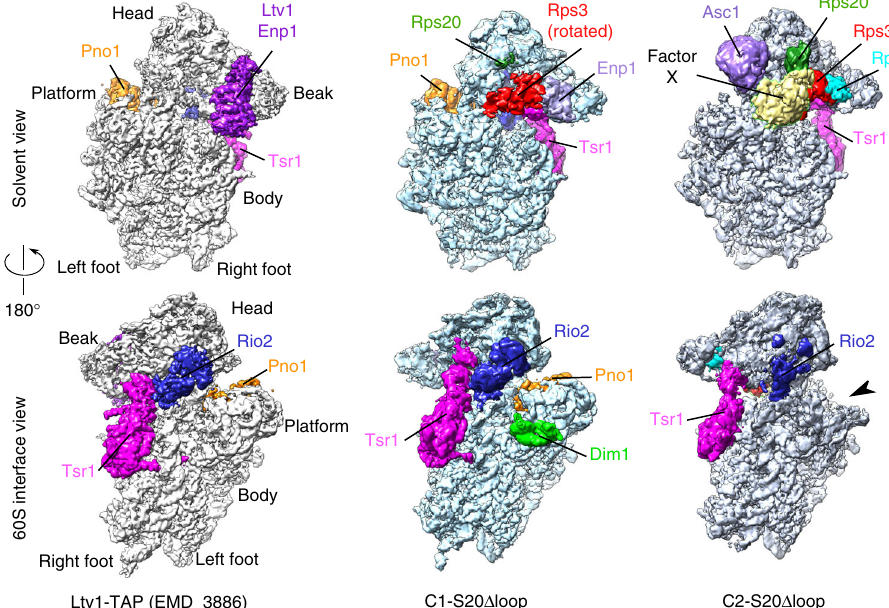
Fig. 5 Cryo-electron microscopic (cryo-EM) analysis of Rps20 Δ loop pre-40S particles. Surface views of cryo-EM maps of Ltv1-puri fi ed wild-type pre-40S particles 16 (left panel) and the Rps20 Δ loop pre-40S particles (central panel: C1-S20 Δ loop particles; right panel: C2-S20 Δ loop particles). Assembly factors and r-proteins of interest have been segmented and colored; the arrowhead next to the C2-S20 Δ loop map indicates missing density in the platform region compared to the other